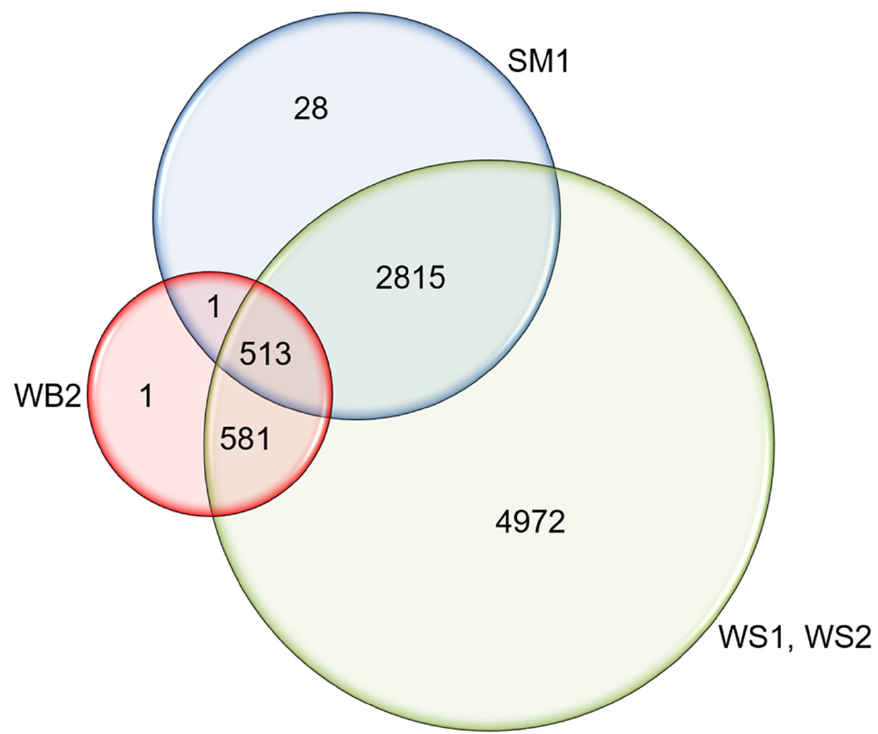
Figure 6. Venn Diagram showing the incidence counts of three myopathies in 8911 fillets. Spaghetti meat (SM) was observed in 3358 fillets, and severe woody breast (WB2) in 1096 fillets. Mild and moderate white striping (WS1 and WS2) were observed in 8881 fillets. The co-occurrence of SM and WB2 was observed in 514 fillets (Note: out of 9250 scored fillets, only 339 fillets did not show myopathies). Reproduced from Che et al. [37] with permission.